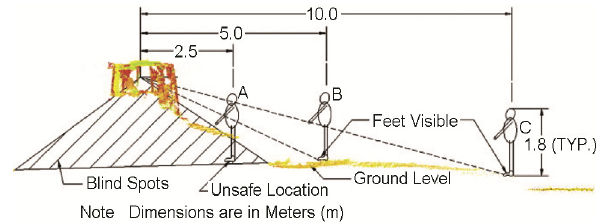
Fig. 10. Worker’s visibility at different locations (A, B, and C) close to equipment (Teizer et al.